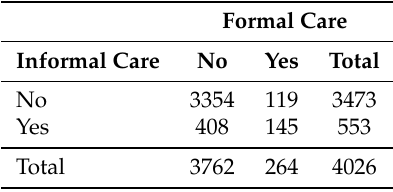
Table 4. Confusion matrix of informal and formal LTC